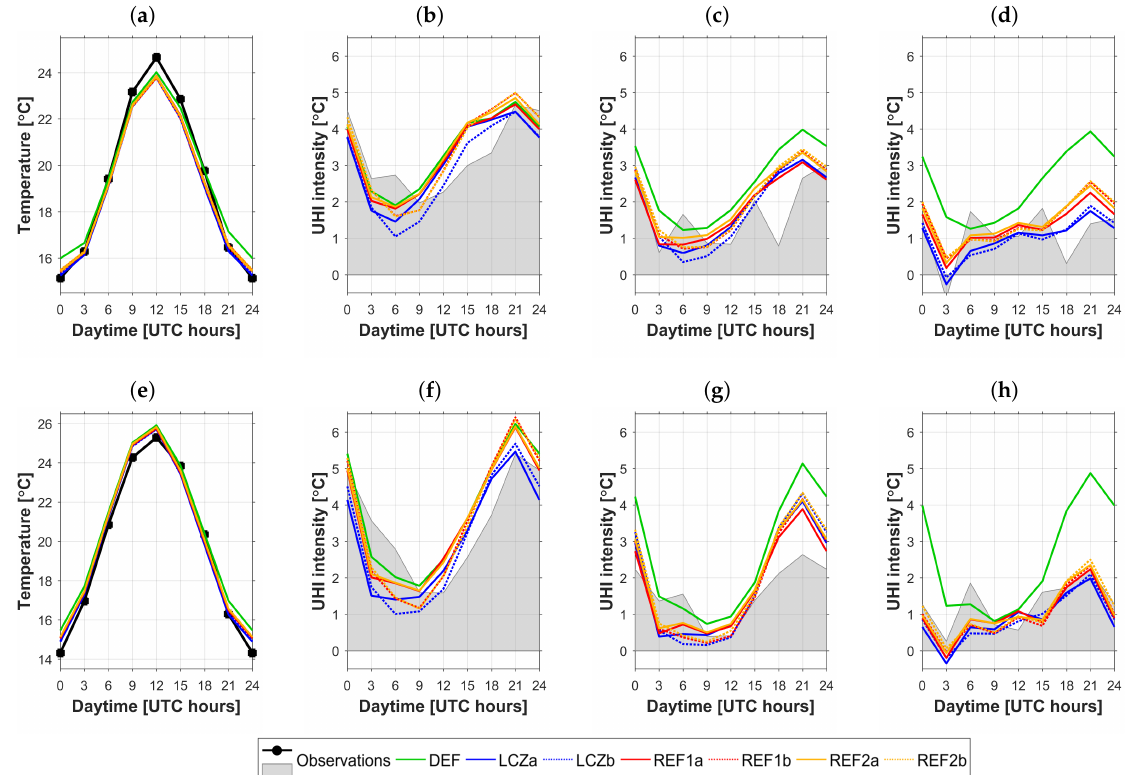
Figure 8. Diurnal cycles of the mean rural temperature ( a , e ) and UHI intensity for Balchug WS in the city center ( b , f ), MSU ( c , g ), and VDNKh ( d , h ) WSs in urban parks for the selected sub-periods in August 2017 ( a – d ) and June 2019 ( e – h